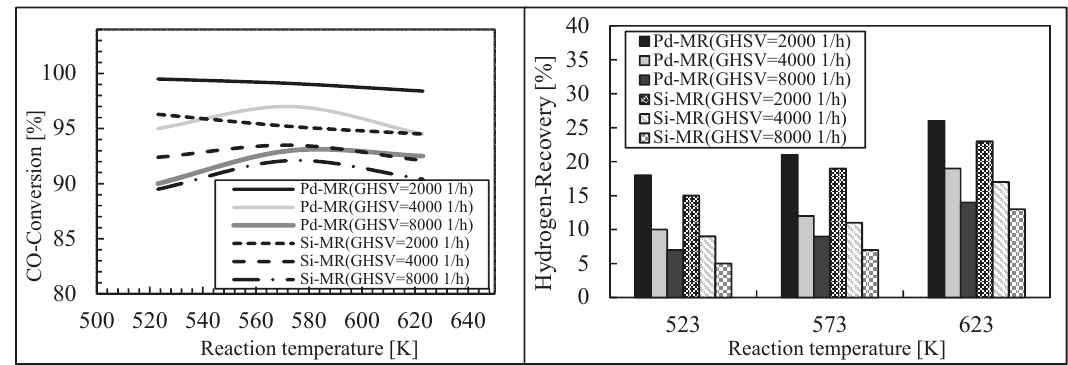
Figure 13. CO conversion and hydrogen recovery vs. reaction temperature for the dense Pd-Ag and silica MRs and TR at 3 atm, H 2 O/CO = 1 and three different space velocity values. With permission to reprint from Elsevier by Ghasemzadeh et al. [46].